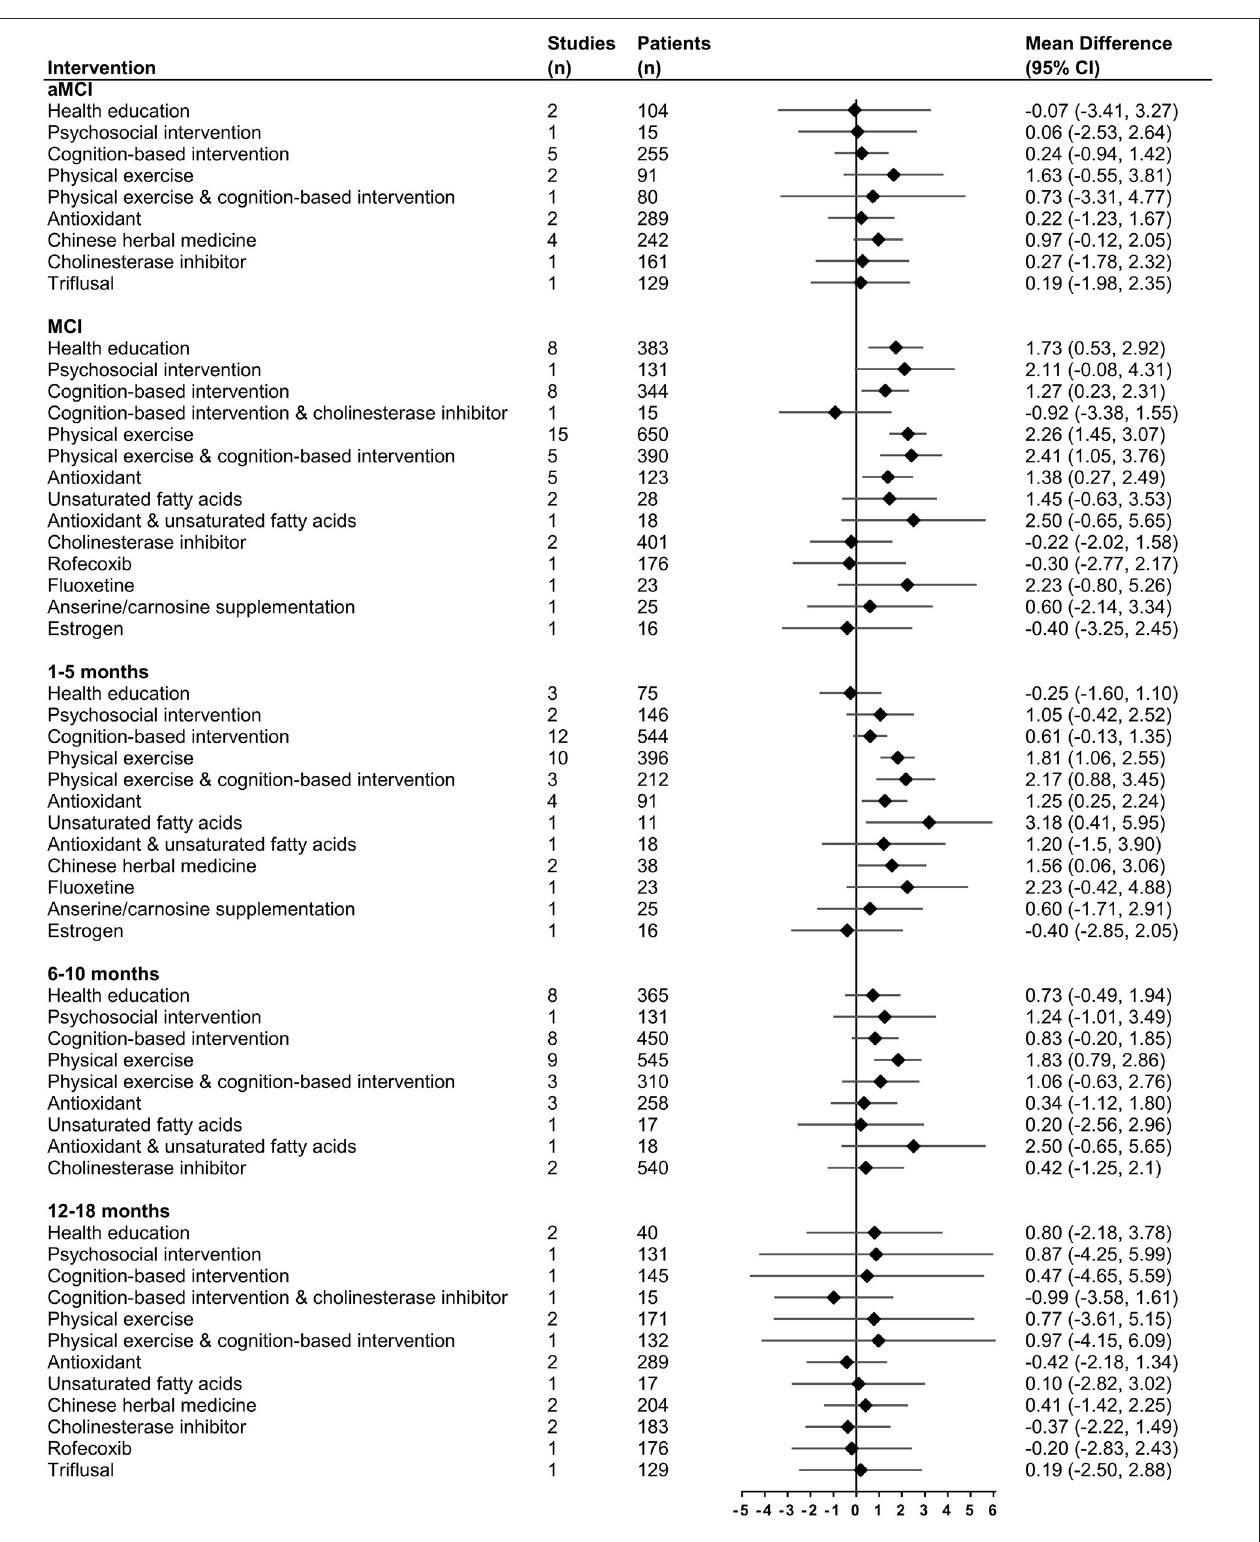
FIGURE 4 | Effect size in subgroup analysis for change in MMSE compared with control group using forest plots.